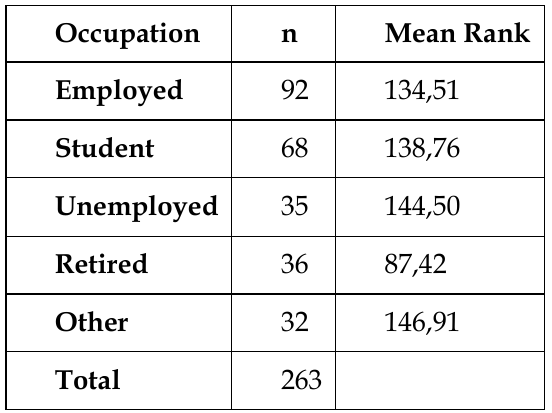
Table 29. Willingness to use the Digital Health Centre and occupation. Kruskal-Wallis mean rank.